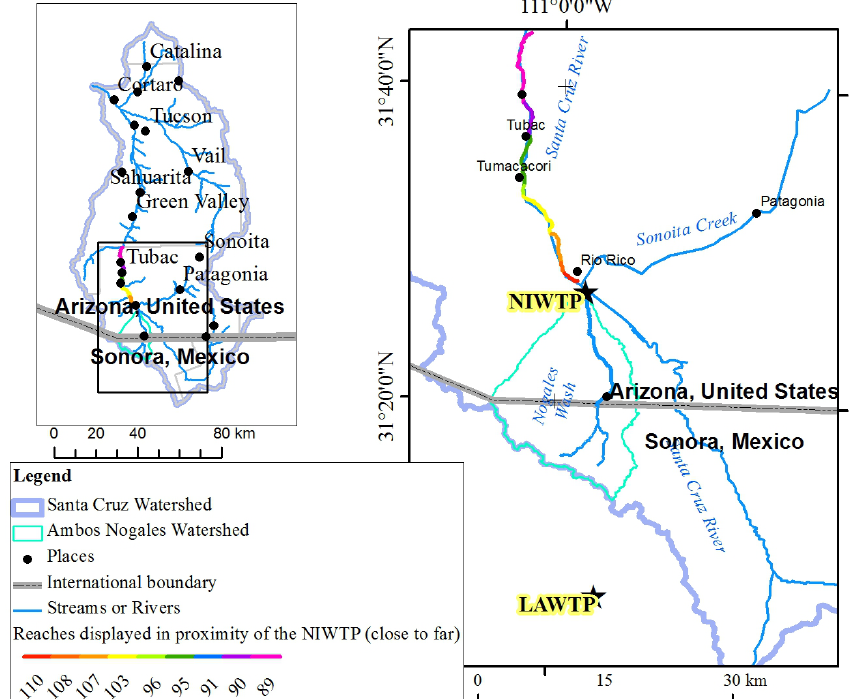
Figure 2. Map of the Santa Cruz Watershed with close-up view (right) showing the location of the Nogales International Wastewater Treatment Plant (NIWTP) in relationship to the rivers and streams, places, watershed boundaries and the Los Alisos Wastewater Treatment Plant